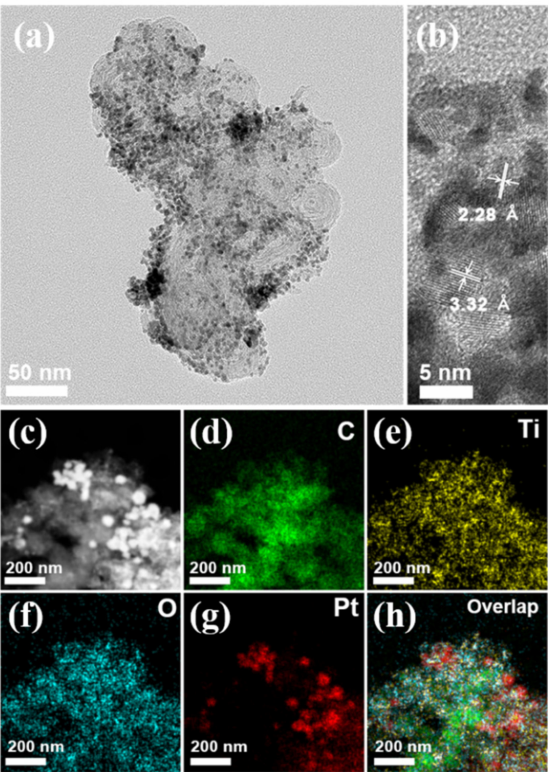
Figure 4. ( a ) TEM and ( b ) HR-TEM images of Pt-TiO 2 -SP. ( c ) HAADF-STEM image and ( d – h ) the corresponding EDS elemental mapping images of Pt-TiO 2